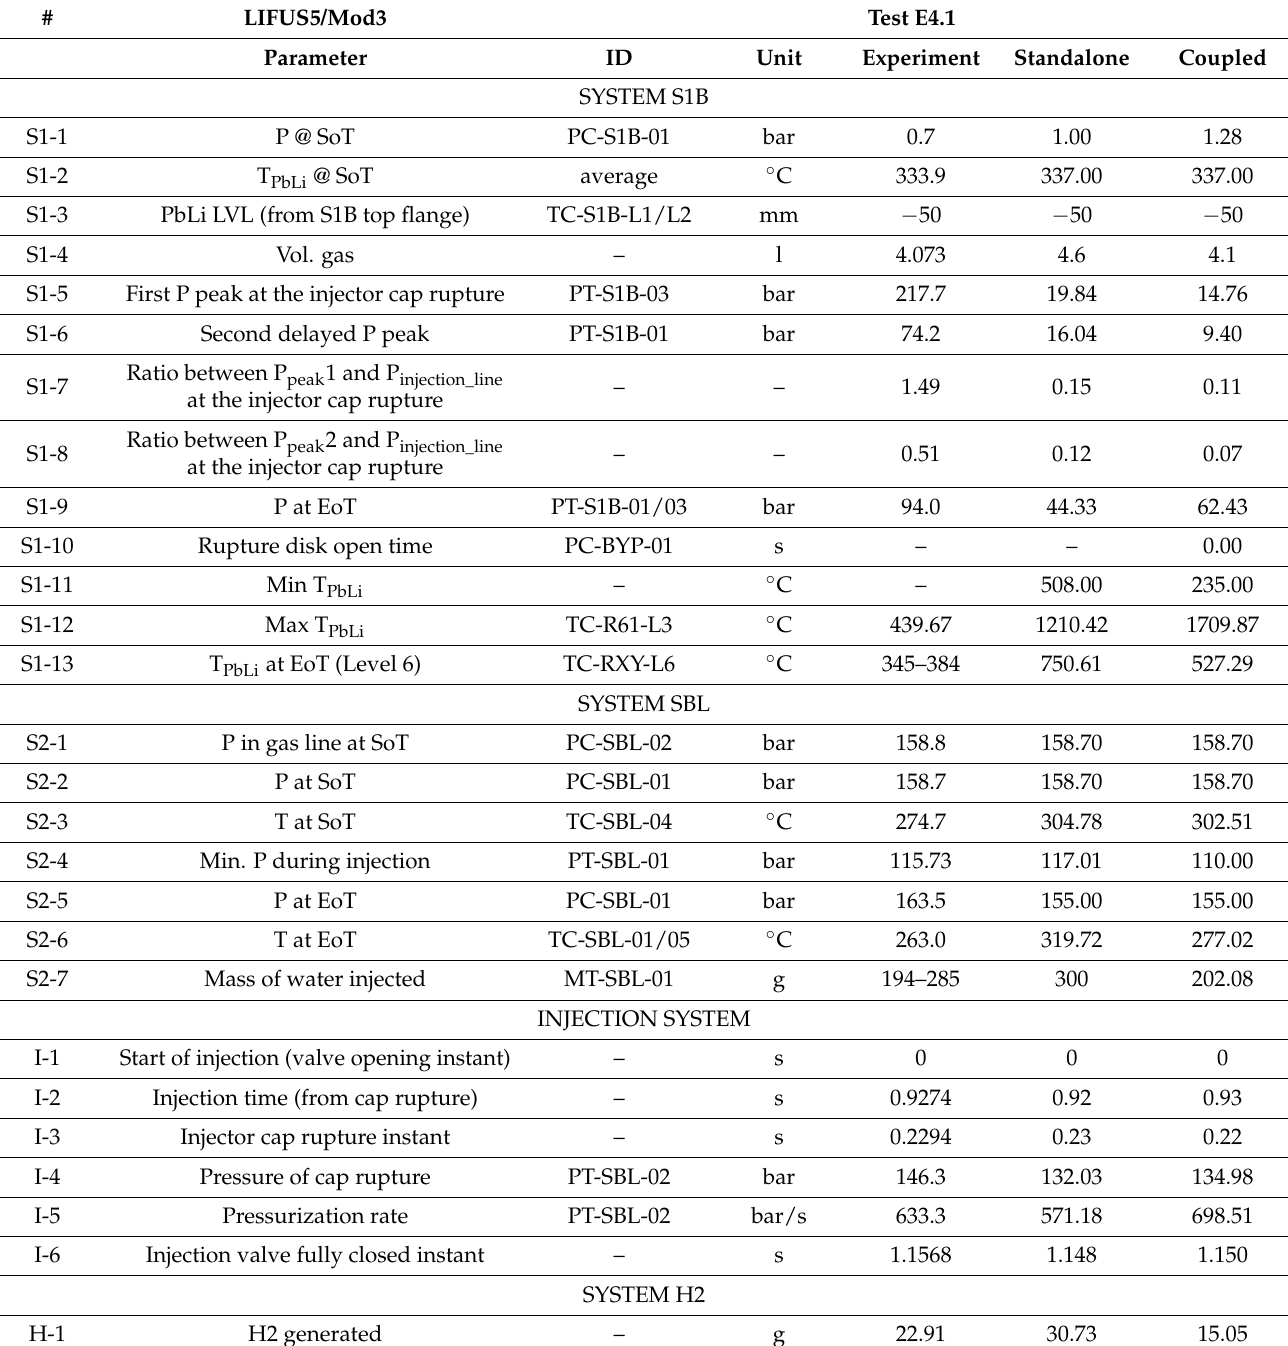
Table 7. Test E4.1, main